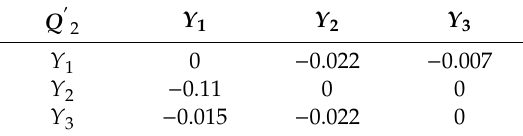
Table 19. The regret matrix Q (cid:48) 2 .